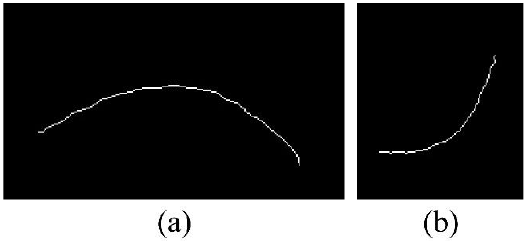
Figure 10. Visualization of the improved ZS thinning algorithm. ( a , b ) The pest skeleton images ex- tracted from Figure 7a,d. extracted from Figure 7a,d.